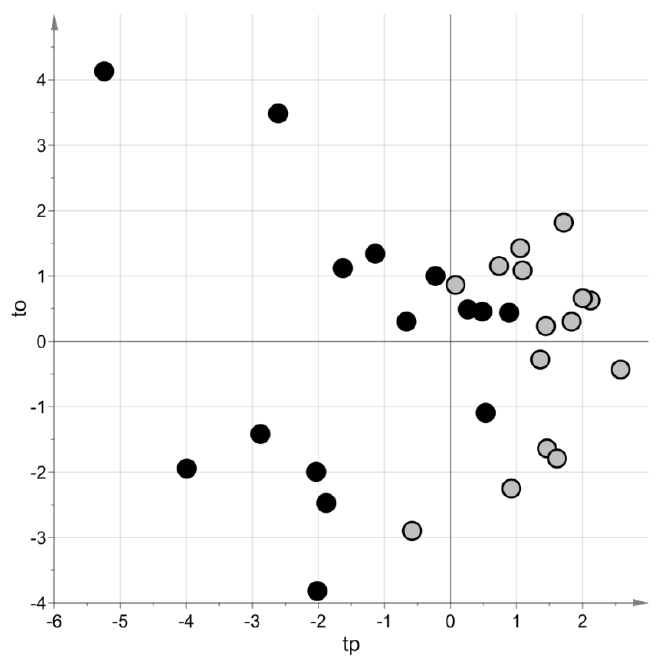
Figure 3. Targeted metabolomic investigation: score scatter plot of the PLS–DA model built using the blood samples. Samples from cases of sepsis are indicated with black circles, those from controls with light grey circles. The PLS–DA model has been post-transformed to obtain the predictive latent variable tp and the non-predictive latent variable to [29].